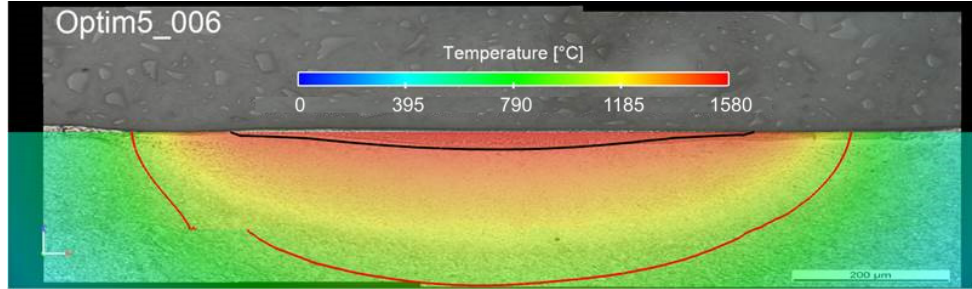
Figure 2. Comparison between FEM simulation based on the model developed by Meylan et al. [22] and an experiment using the process parameters of Optim5 in Table 4.